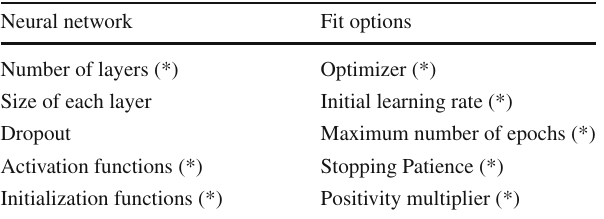
Table 2 Parameters on which the hyperparameter scan is performed. Results marked with (*) are shown graphically in Fig. 3 Neural network